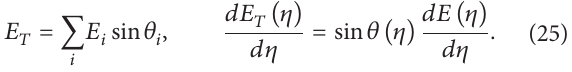
Figure 33: 𝑁 𝛾 normalized per participant pair as a function of 𝑁 for Cu+Cu collisions.